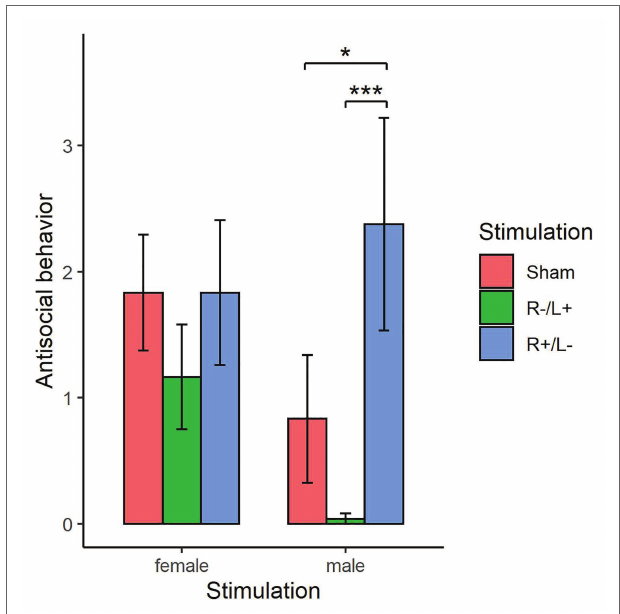
FIGURE 6 | Antisocial behavior exhibited by females and males at a cost of 1:3 tokens under three stimulation conditions. Error bars indicate 95% CI. Asterisks indicate significant differences in behavior among